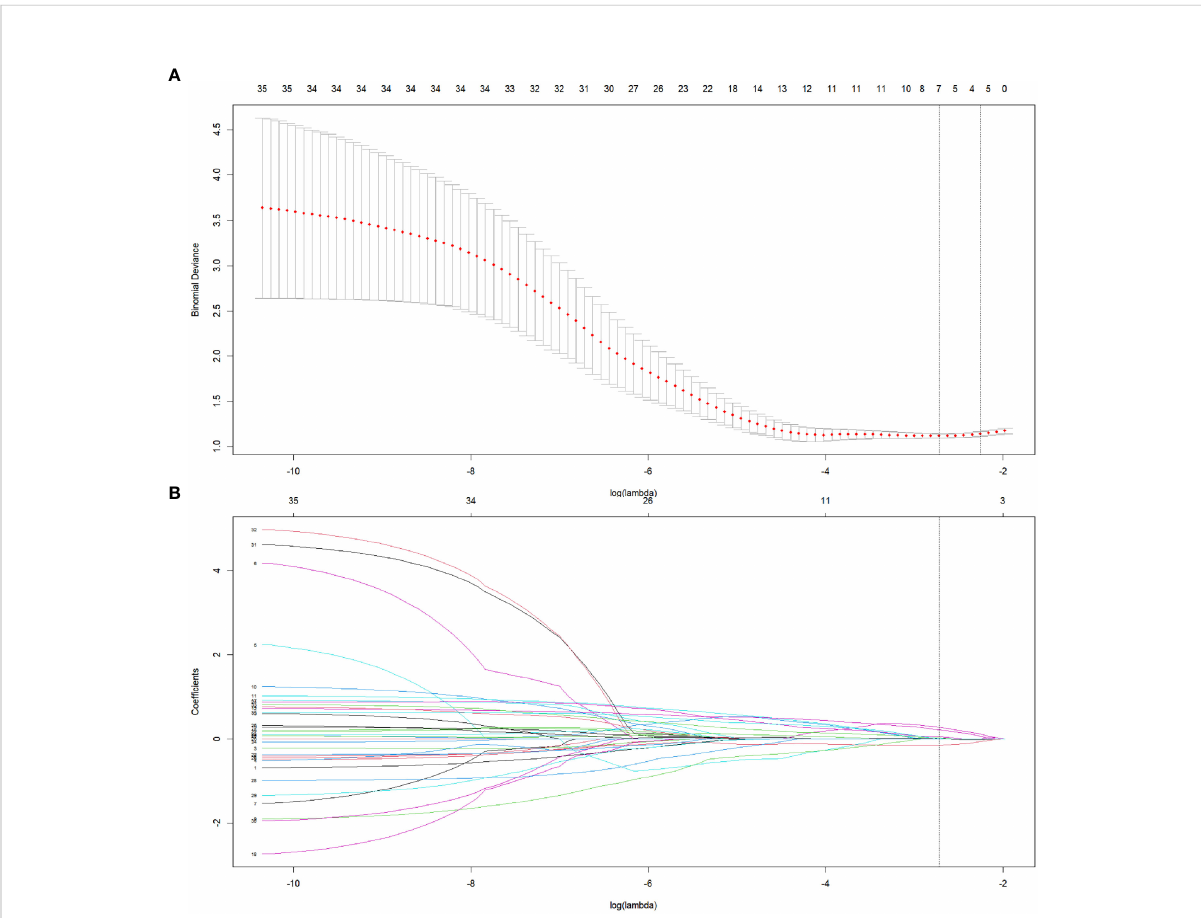
FIGURE 2 The selection of radiomics features in LASSO regression. (A) The association between binomial deviance and log (lambda) was plotted, and two vertical line were drawn via the minimum deviance and 1 standard error of the minimum deviance, respectively. Based on the minimum criteria, the optimal lambda was selected according to 5-fold cross-validation. (B) LASSO coef fi cient distribution of radiomics features by different log (lambda) values. The vertical line was drawn at the optimal value of l , leading to 7 features with nonzero coef fi